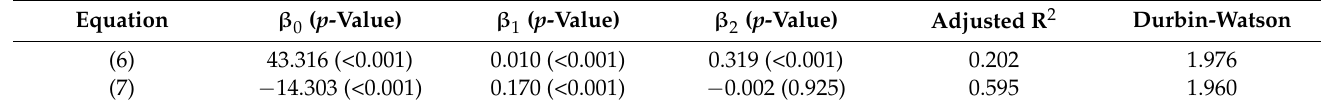
Table 2. Results of linear regressions for burglary density and stable